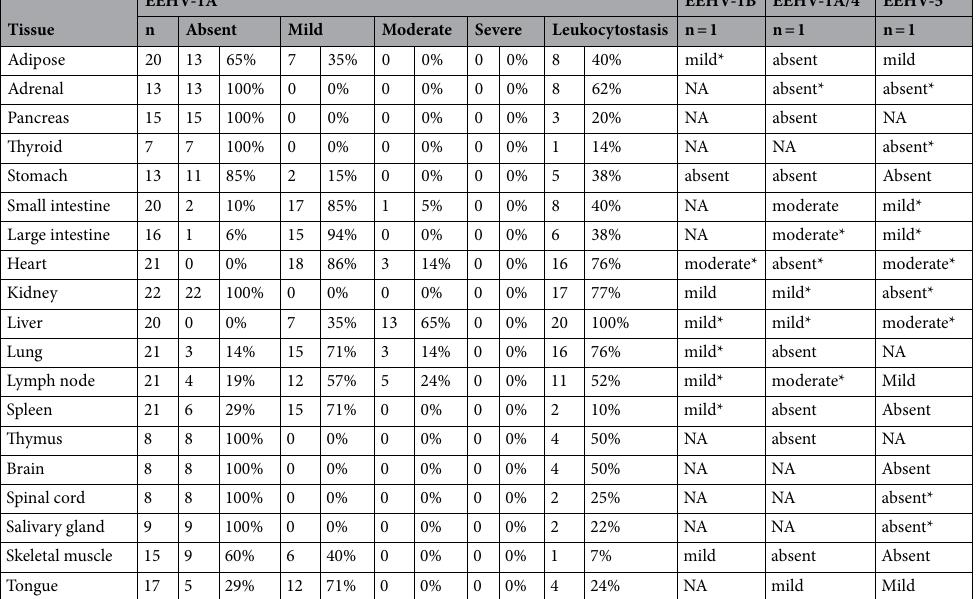
Table 4. Inflammation scores and presence of leukocytostasis in organs from Asian elephant endotheliotropic herpesvirus-haemorrhagic disease fatalities in Europe. NA; tissue not available, * leukocytostasis